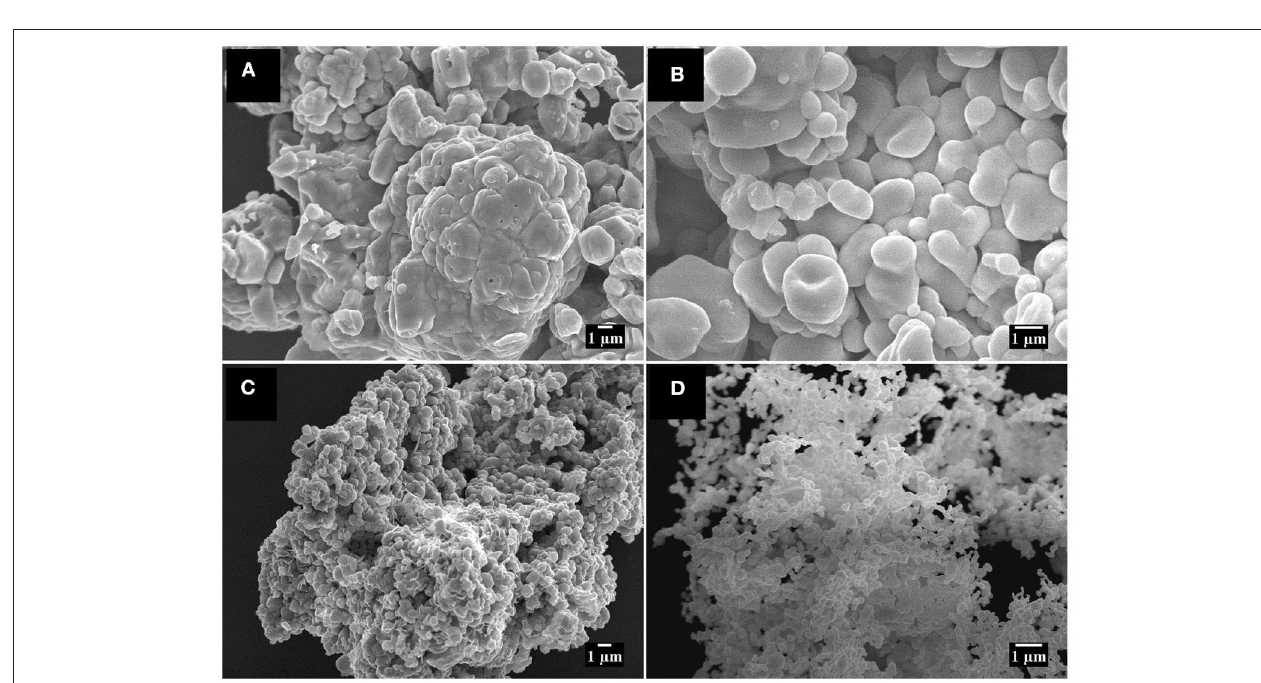
FIGURE 2 | SEM image (A) 4,000x (B) 8,000x Zn-AL; and (C) 4,000x (D) 8,000x